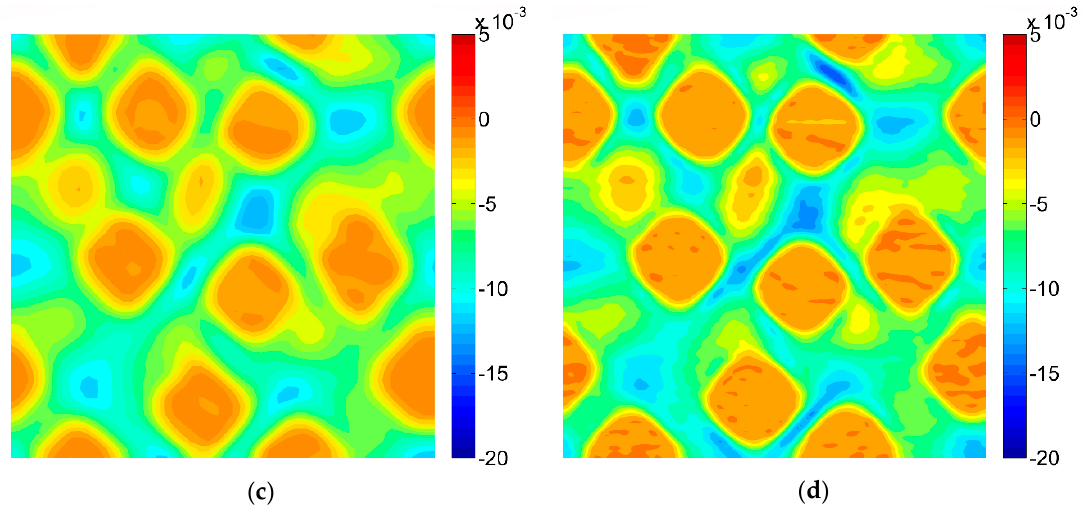
Figure 11. Distribution of strain ε 22 obtained for Material 1 with consideration of different speckle sizes, grid of squares: ( a ) 50 × 50, ( b ) 100 × 100, ( c ) 150 × 150, ( d ) 200 × 200.